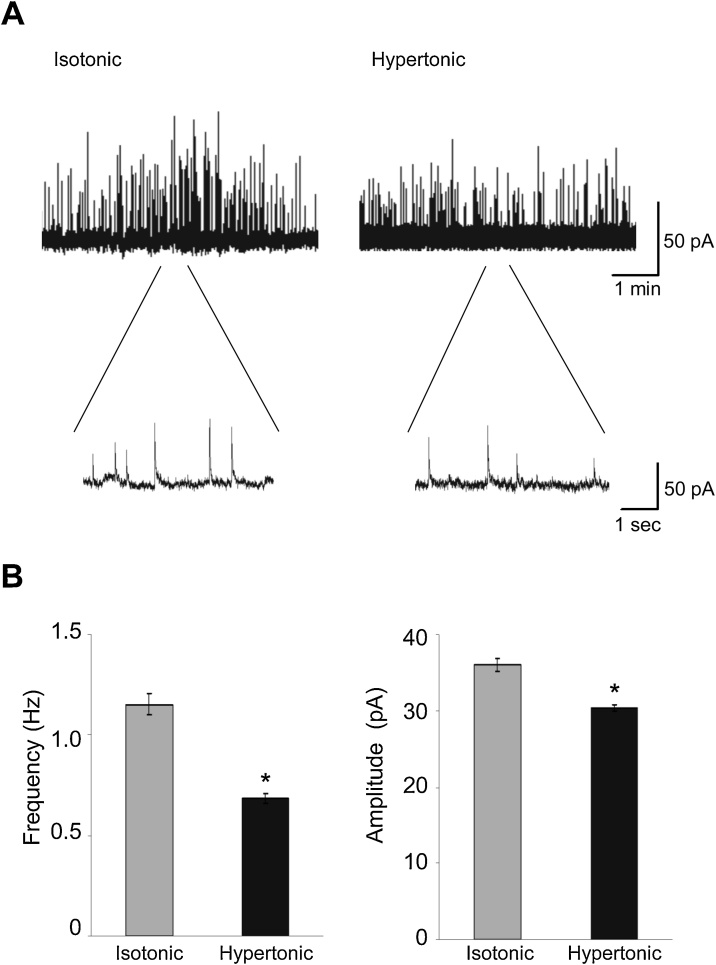
(A, representative examples of the miniature GABAergic postsynaptic currents (mGPSCs) after 2 h incubation in the isotonic (300 mOsmol/kg) and hypertonic (350 mOsmol/kg) condition are shown. (B, under persistent hypertonic conditions, both the frequency (isotonic: 1.15 ± 0.05 Hz, n = 19; hypertonic: 0.68 ± 0.03 Hz, n = 32, p < 0.05) and the amplitude (isotonic: 36.1 ± 0.78 pA, n = 19; hypertonic: 30.4 ± 0.38 pA, n = 32, p < 0.05) of mGPSCs were significantly smaller relative to isotonic conditions.